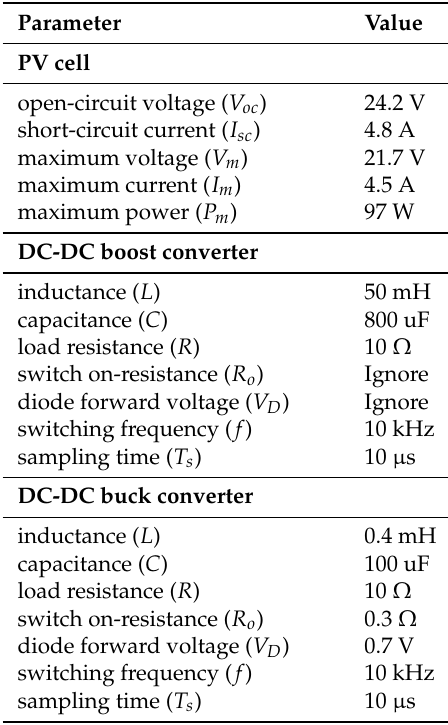
Table A1. The key parameters of PV